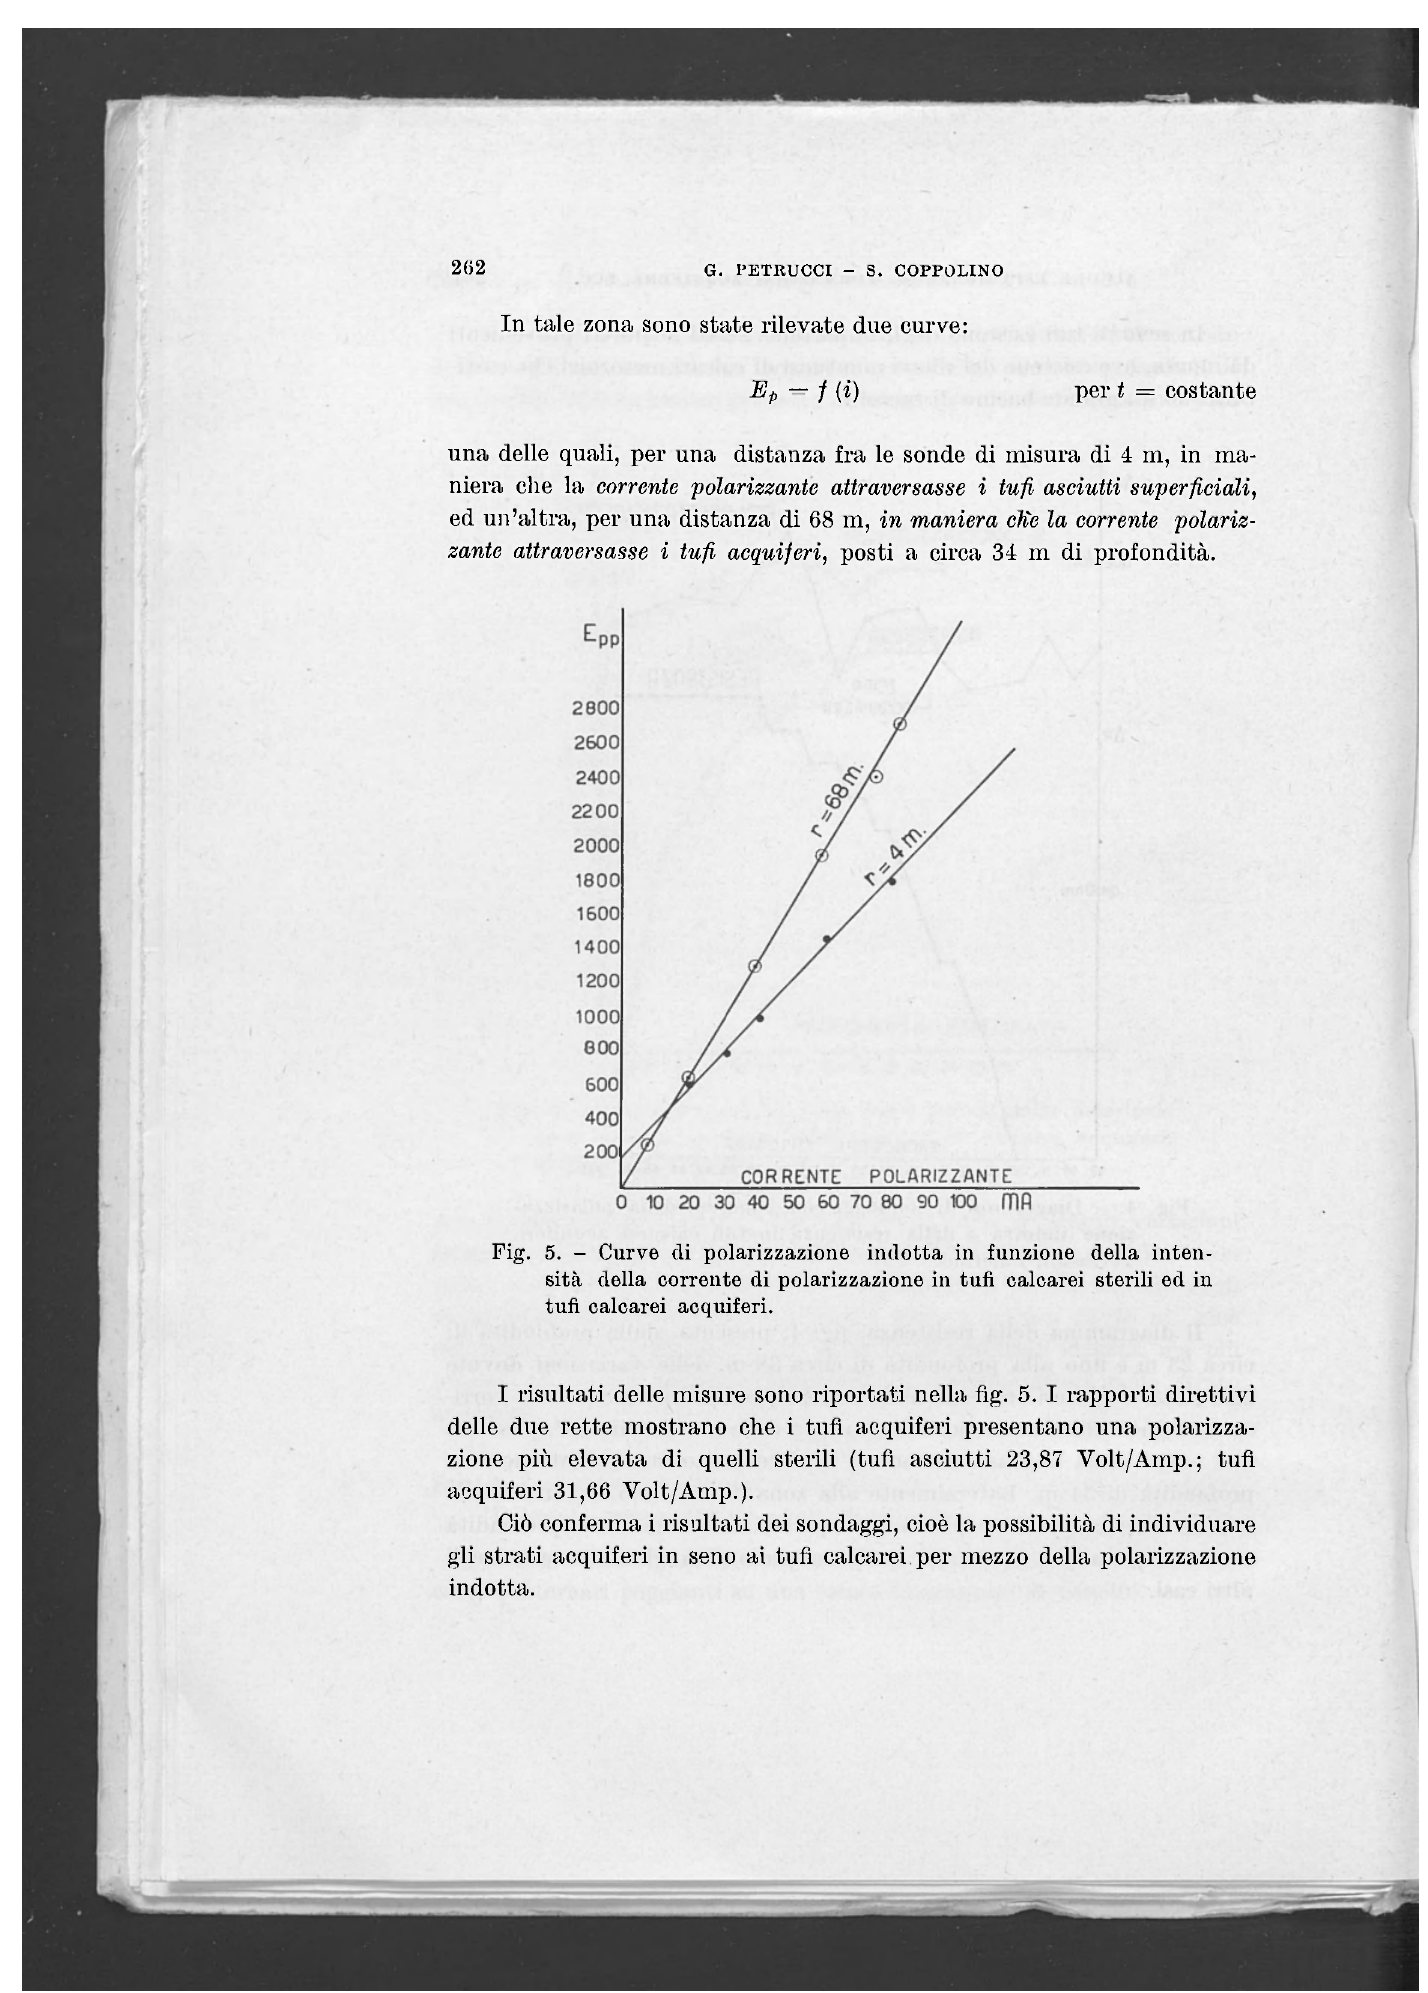
Fig. 5. - Curve di polarizzazione indotta in funzione della inten- sità della corrente di polarizzazione in tufi calcarei sterili ed in tufi calcarei